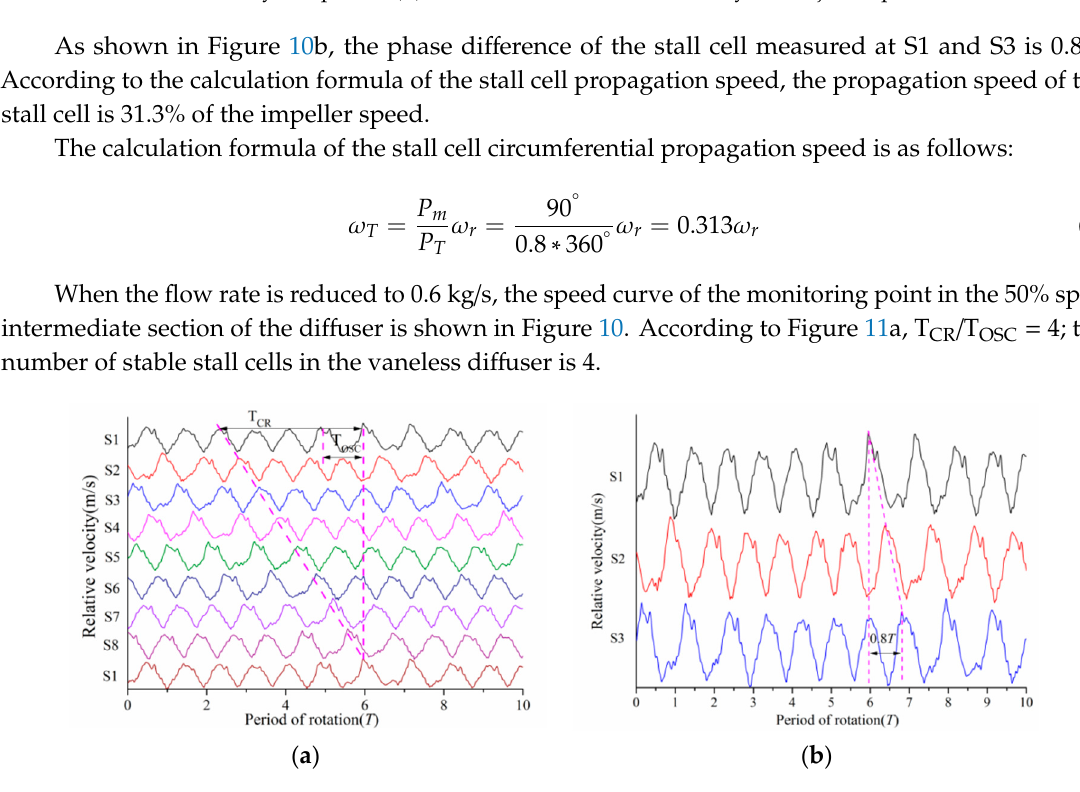
Figure 11. Relative velocity curve of the monitoring point when the flowrate is 0.6 kg / s: ( a ) the curve of the relative velocity at 8 points; ( b ) the curve of the relative velocity at 3 adjacent points.